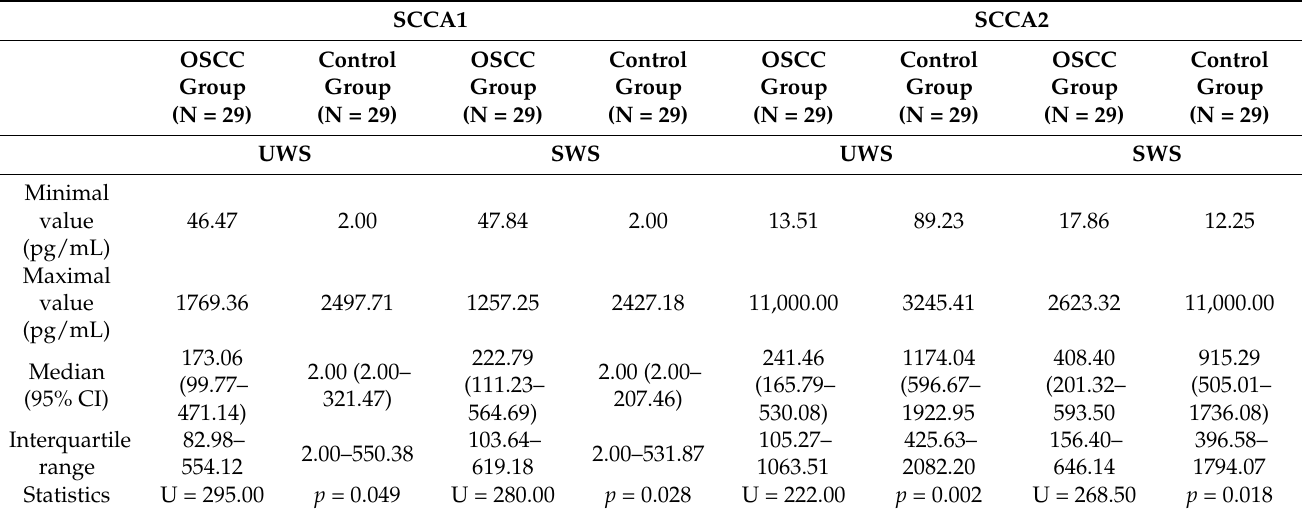
Table 3. Salivary SCCA1 and SCCA2 levels comparison between the OSCC and control group.